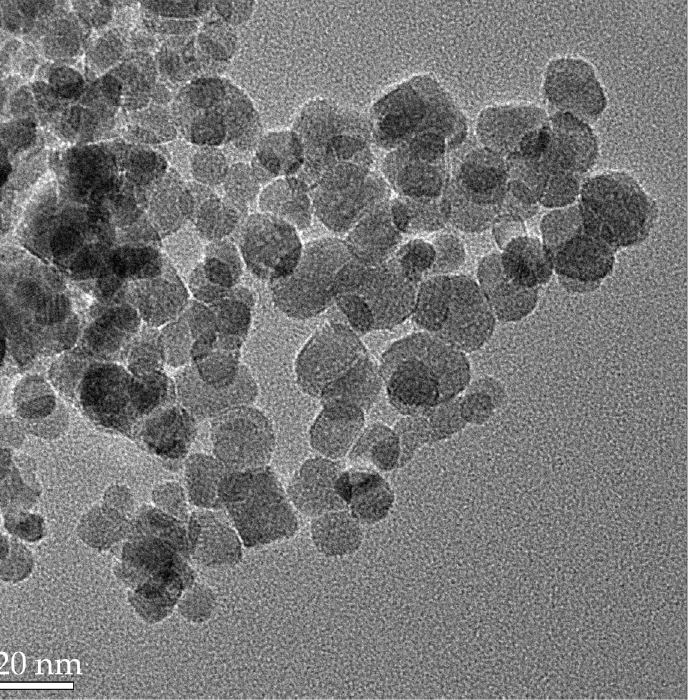
Figure 2. A TEM image of MNPs synthesized via the co-precipitation method (the results obtained in the laboratory of the presenting authors).